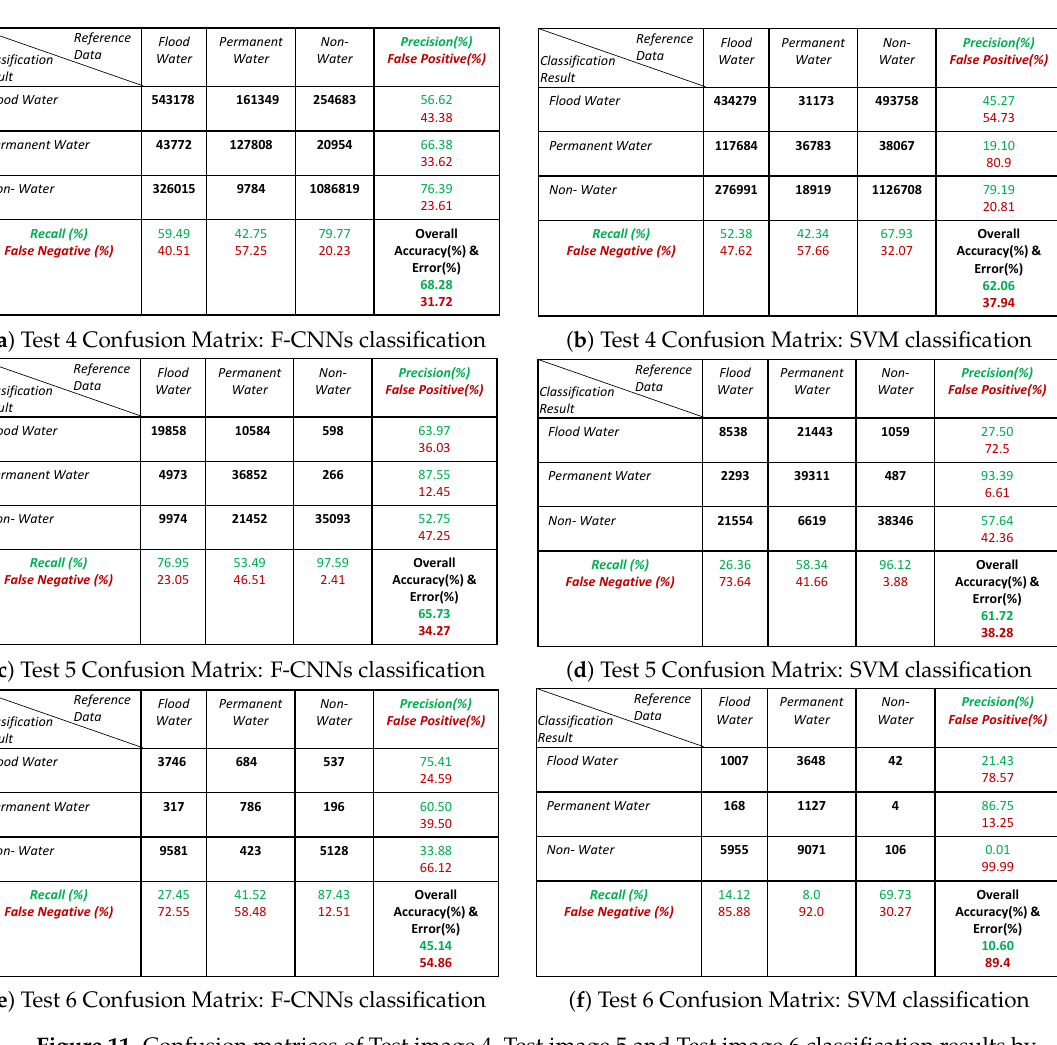
Figure 11. Confusion matrices of Test image 4, Test image 5 and Test image 6 classification results by F-CNNs and SVM: Confusion matrix listed the accuracy